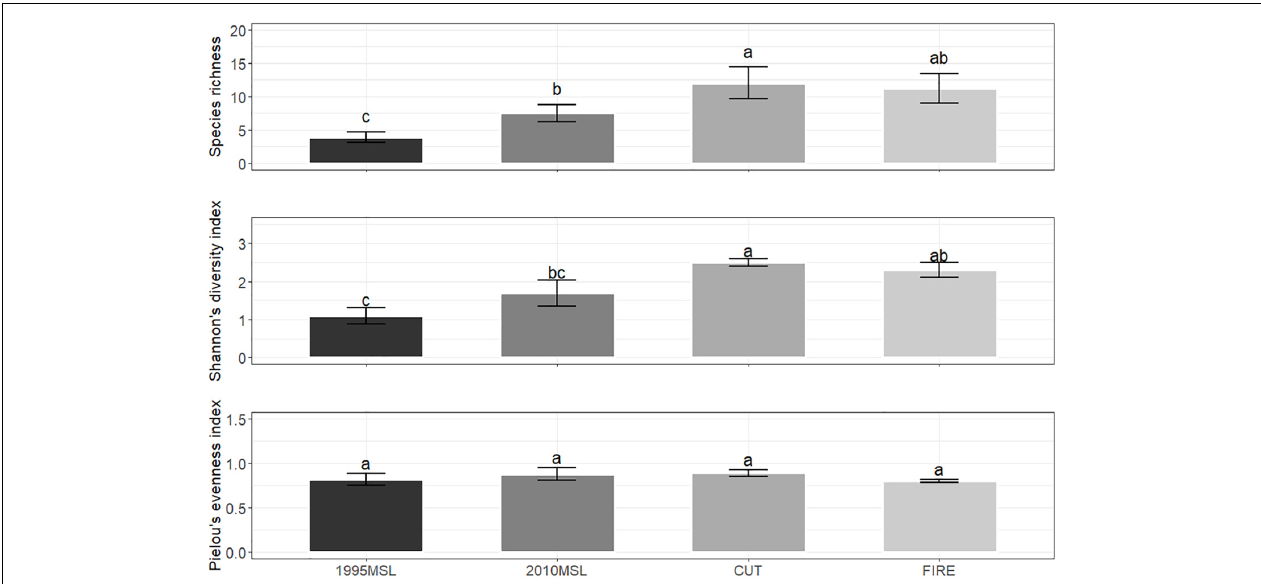
FIGURE 4 | Least squares means (lsmeans) of species richness (species per plot) (A) , Shannon’s diversity index (B) , and Pielou’s evenness index (C) by reclaimed (1995 and 2010MSL) and reference (CUT and FIRE) site types. Letters indicate significant differences between treatments after Tukey adjustment ( P < 0.05). Mean ( ± SE) values with different lowercase letter(s) were significantly different among the site types at P < 0.10.